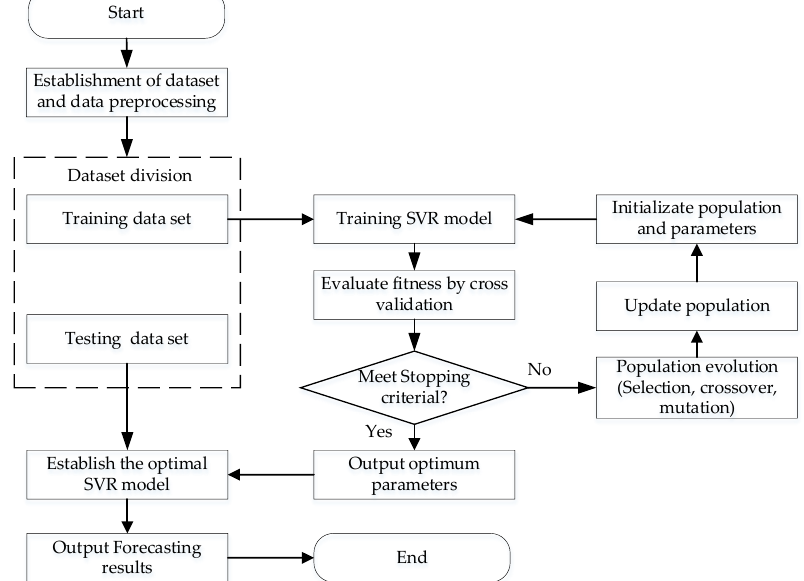
Figure 6. Flowchart of parameter optimization of HKF-SVR.